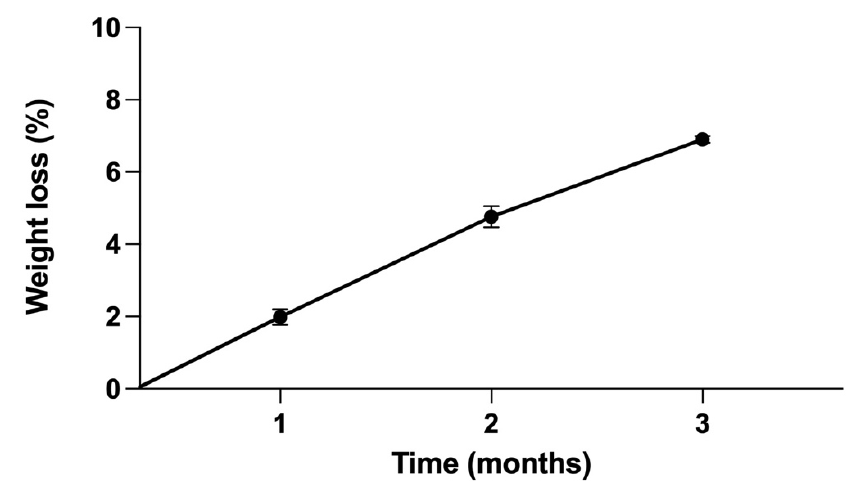
Figure 7. In vitro corrosion characteristics of the Fe SA. Mean ± SEM.